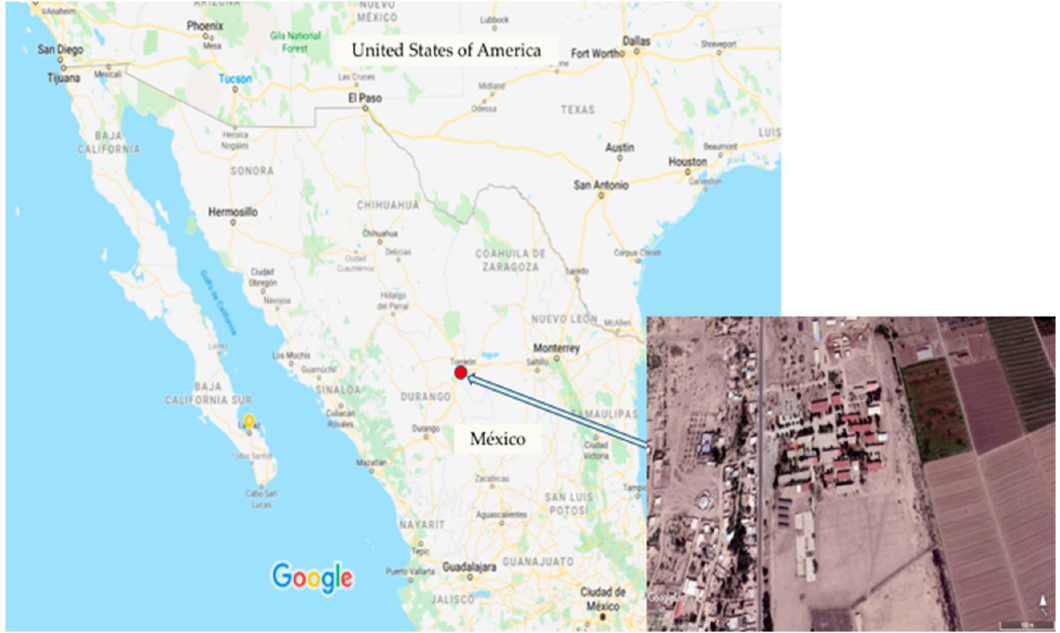
Figure 1. The geographic location of the Agriculture and Zootechnics Faculty, Juarez University of the State of Durango, northern Mexico.